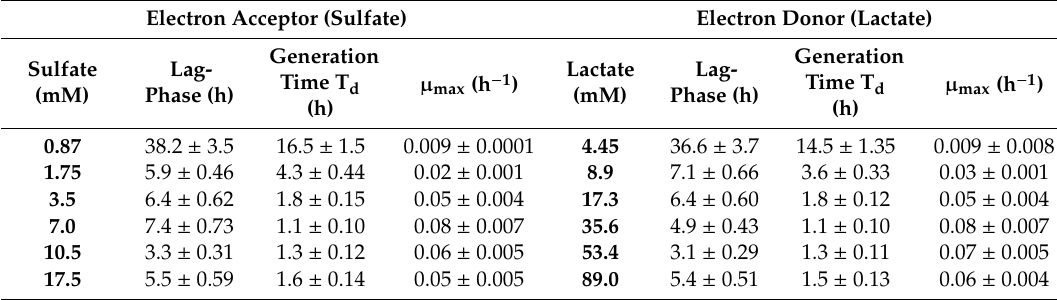
Table 1. Kinetics of D. piger Vib-7 growth under the effect of electron acceptor/donor.